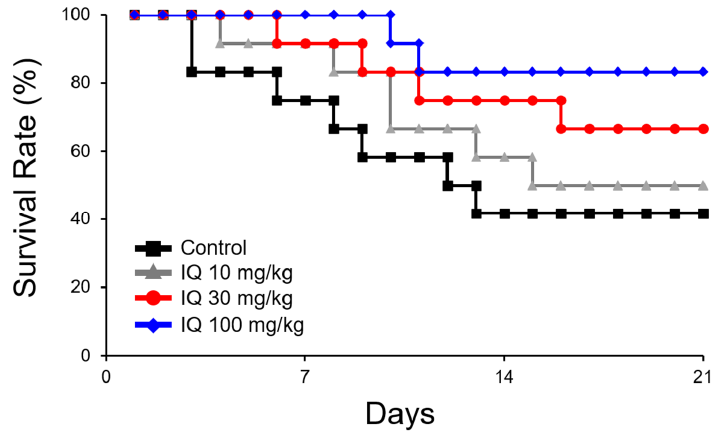
Figure 1. Effect of isoquercitrin (IQ) on mortality caused by cardiovascular anaphylaxis in pithed rats. Male Wistar rats ( n = 12 per group) were intraperitoneally sensitized with 10 mg/head of ovalbumin (OVA) on day 1 and 2. Survival rate was observed for 20 days. DMSO was used as the control.